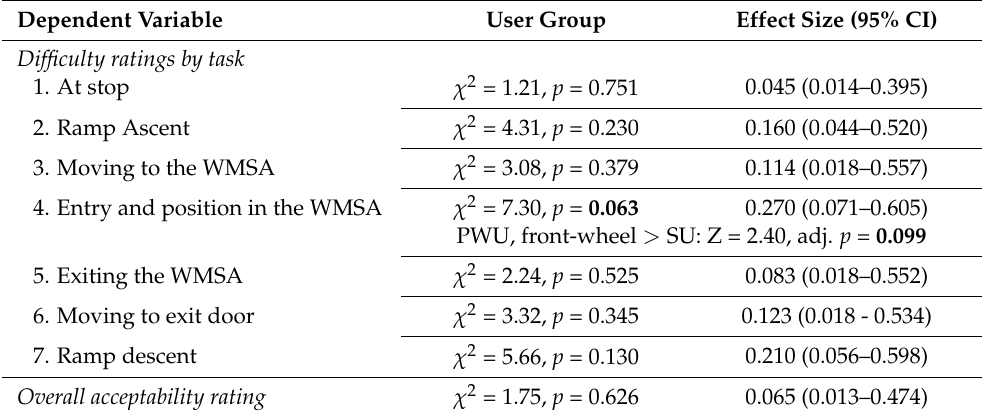
Table 6. Summary results from the non-parametric Kruskal–Wallis tests examining effects of user group (n = 28) on task difficulty ratings ( − 3 = very difficult; +3 = very easy) and overall acceptability rating ( − 3 = very unacceptable; +3 = very acceptable). Values in bold indicate significant effects at p < 0.10.